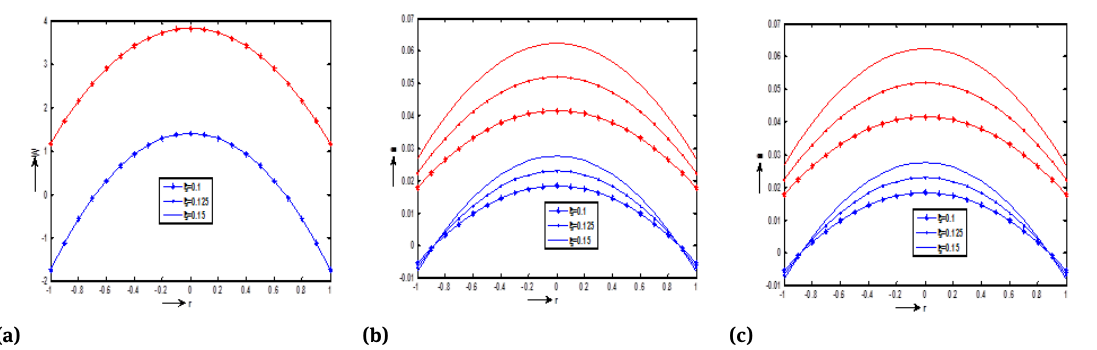
Fig. 3: (a) Velocity profile for various values of ξ (b) Temperature profile for various values of ξ (c) Pressure gradient for various values of